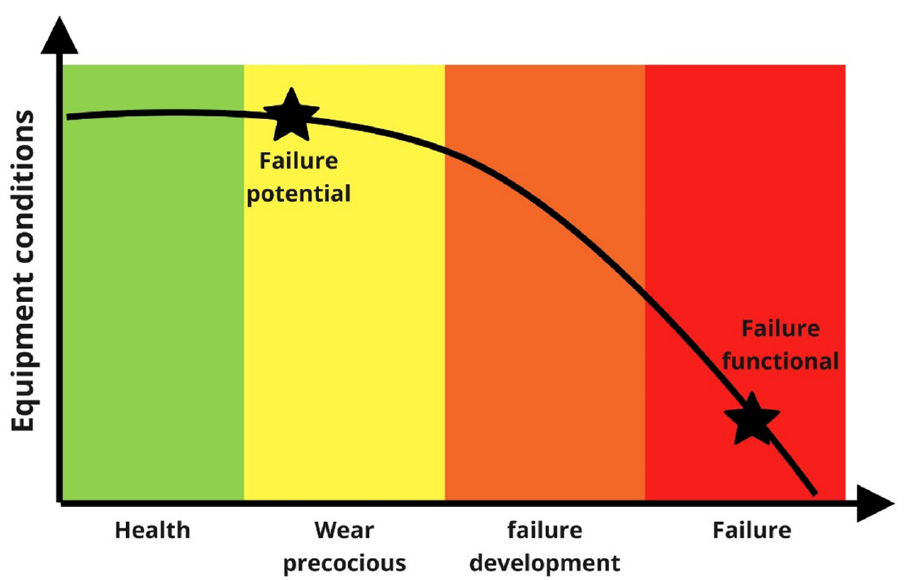
Figure 3. PF curve represents the condition of a component until functional failure. Source: Adapted from [52].